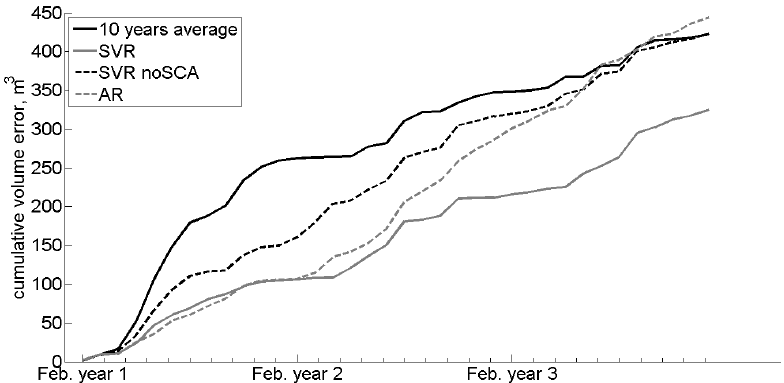
Figure 9. Cumulative volume errors of the one-month lead time forecast during the three test years ( i.e. , 2005, 2010, 2011) relative to the catchment closed at Ponte Adige ( n . 7). Table 3. Performances of different SVR model configurations for all stations. The fourth and fifth column refer to the mean RMSE% and R square computed over the test samples of the 14 watersheds. In the third column “disch” stands for discharge and “temp” for air temperature. The notation— n : 0 stands for a time series of length n − 1 starting from the n -th previous month to the current month from where the discharge prediction is